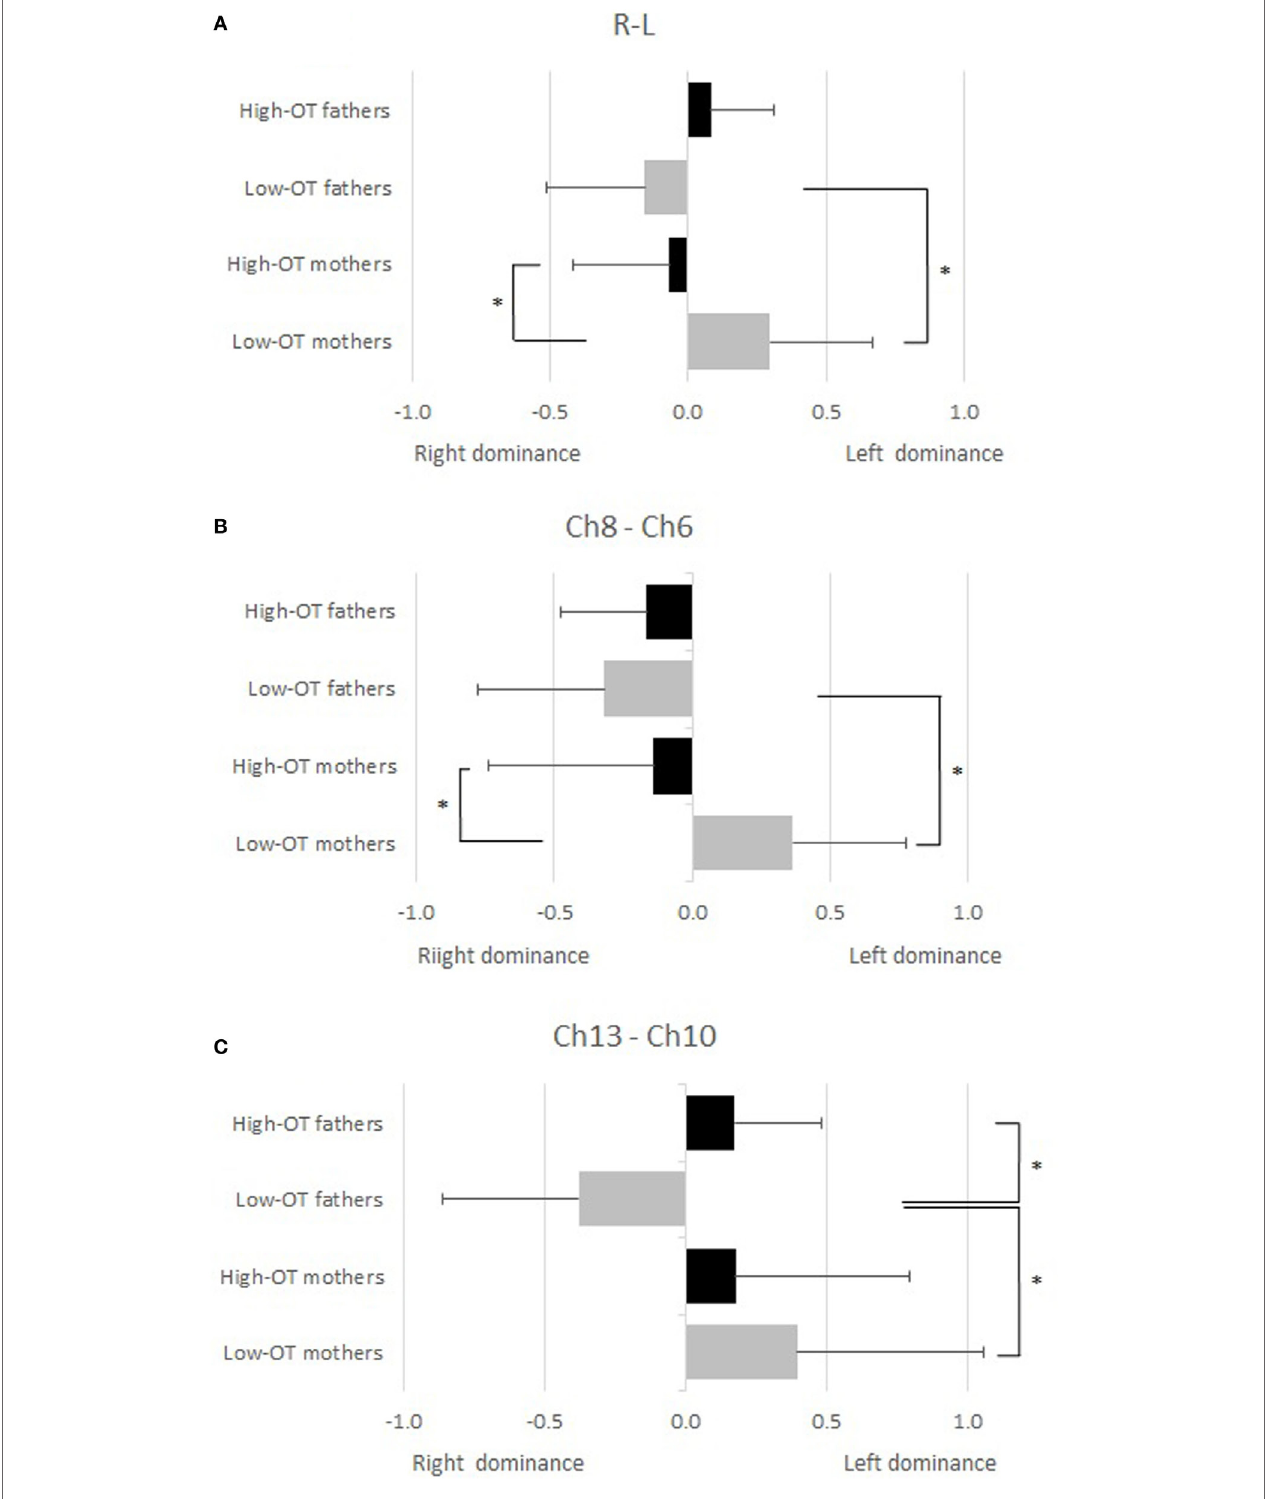
FigUre 3 | A two-way factorial ANOVA was conducted for the laterality indexes (LI) of the pair of functional near-infrared spectroscopy channels to mothers and fathers according to the salivary oxytocin (OT) level (high and low). Significant conditions (simple main effect, p < 0.05) are indicated by asterisks. (a) Mean signal change among the left four channels (Ch L; Ch1, 5, 6, 10) and the right four channels (Ch R; Ch4, 8, 9, 13). (b) LI between Ch6–8. (c) LI between